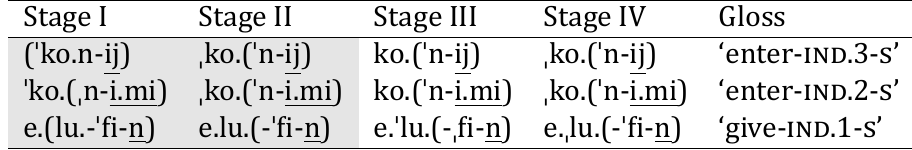
Table 20: Changes in right-edge verbal stress (feet in parenthesis, OFI underlined, sec- ondary stress marks are proposed ‘demoted’ stresses — key changes in grey)